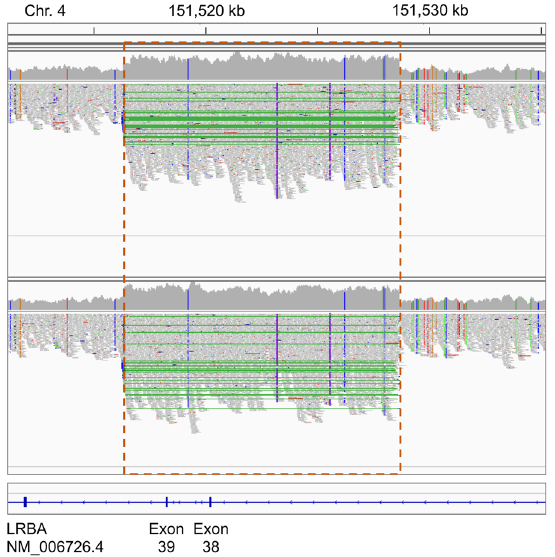
Fig. 1 Read alignments at the copy number gain locus of chromosome 4. Read alignments for the two affected siblings were visualized using the Integrative Genomics Viewer (IGV) 45 . The orange dashed box indicates the duplicated region (copy number 4); green lines indicate paired-end reads spanning the junction between the original reference sequence and the tandem- duplicated sequence; vertical colored lines within the read pile- ups indicate substitutions (note that substitutions supported by multiple reads are all